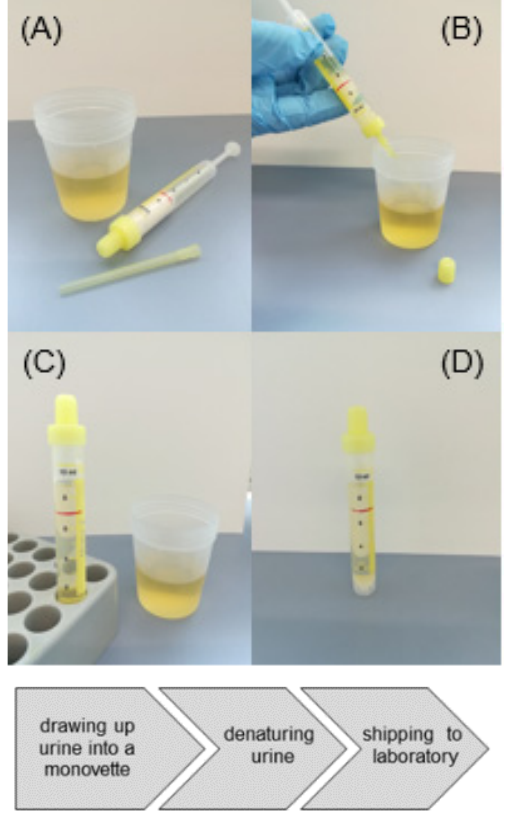
Figure 2. Illustration of soaking a urine sample from a beaker into a monovette (plastic syringe), pre-loaded with GTC ( A , B ). The stamp of the plastic syringe is broken off after filling and the sample is ready for shipping ( C , D ).